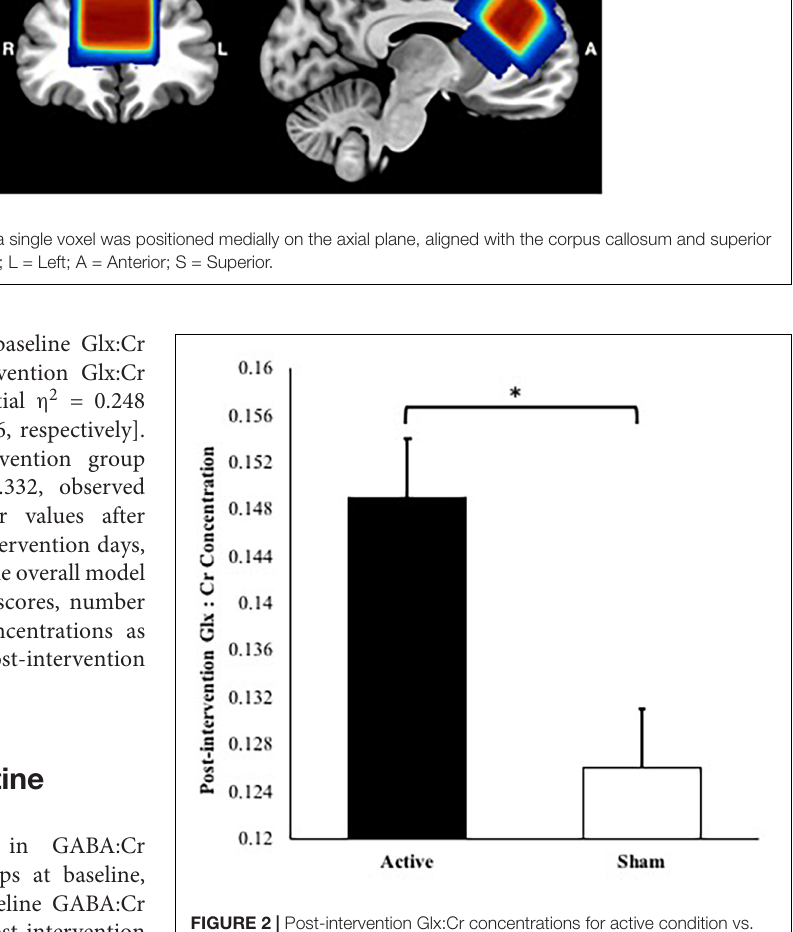
FIGURE 2 | Post-intervention Glx:Cr concentrations for active condition vs. sham condition accounting for age, number of intervention days, MoCA scores, and baseline Glx:Cr concentration ( ∗ p = 0.010). Note : Error bars depict standard errors. Covariates appearing in the model are evaluated at the following values: baseline Glx:Cr = 0.134, age = 73.2, MoCA score = 27.2, number of intervention days =